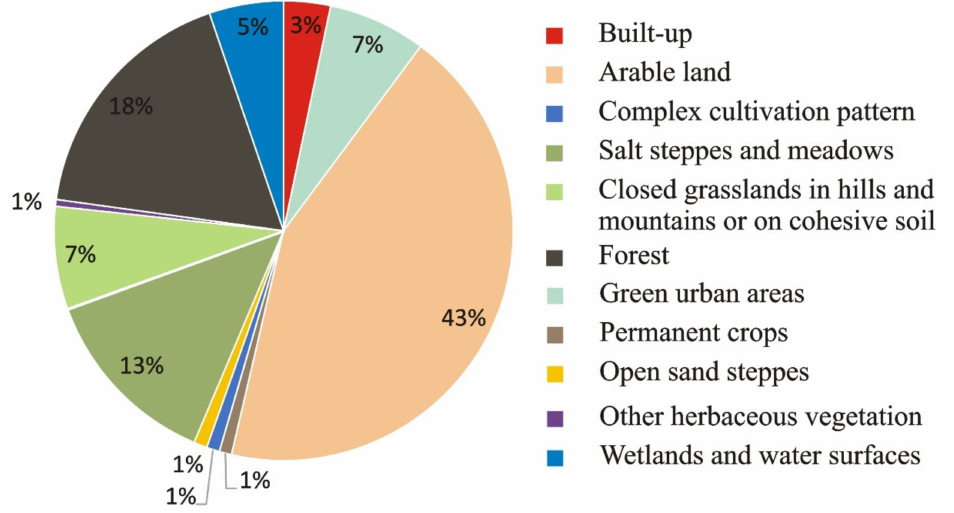
Figure 2. Proportion of the main land cover categories in the 600-m buffer zones, where the Skylark abundance were detected (3049 observation points) based on Hungarian Ecosystem